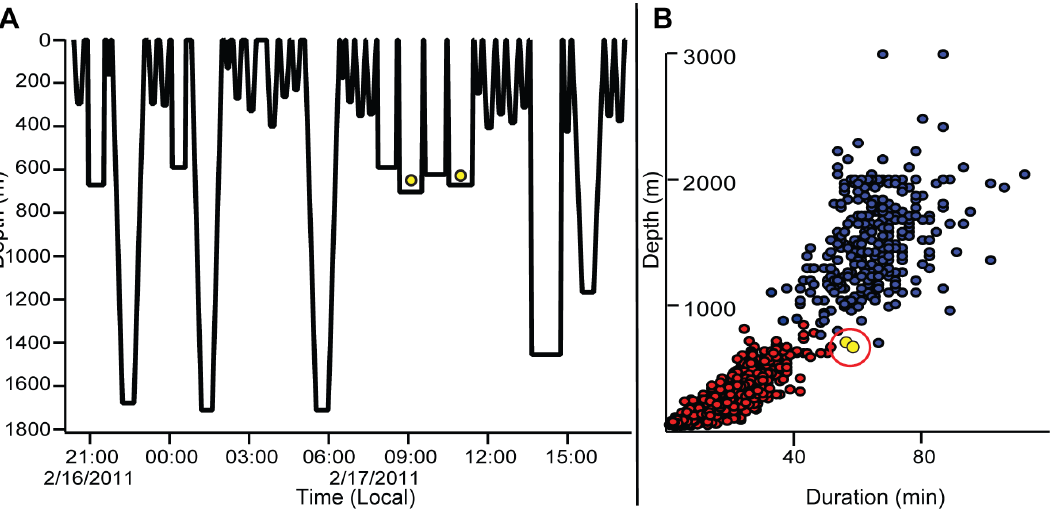
Figure 2. Classification of dive type. ( A )Sample dive trace from Zc015 containing two reclassified dives. The four consecutive dives in the series beginning at 07:49 were all unusually long for shallow dives, but unusually shallow for deep dives, and thus difficult to classify using depth and duration alone. The K-means cluster analysis for Zc015 ( B ) classified the two dives indicated by yellow circles in each panel as deep dives and the other two as shallow dives. All four of these dives in figure A were similar and presumably of the same class. Other deep dives in the adjacent period were up to 1000 m deeper than these two dives, and four deep dives in series would be exceedingly rare based on this dataset and prior studies. Thus, we believe all four of these dives were much more likely to be atypically long, shallow dives, and the two indicated with yellow circles were reclassified as such.